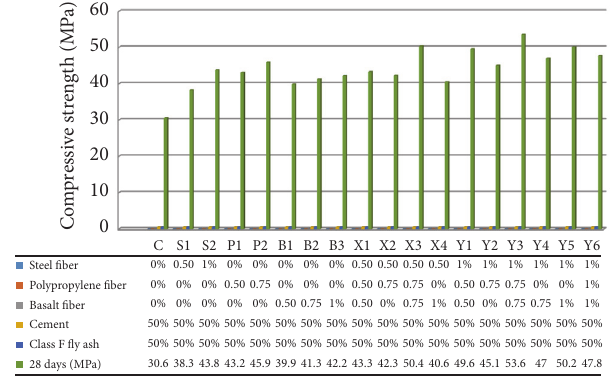
Figure 2: Comparison of compressive strength between control concrete (50% cement, 50% fly ash, and no fibers) and hybrid fiber mixes at 28 days.